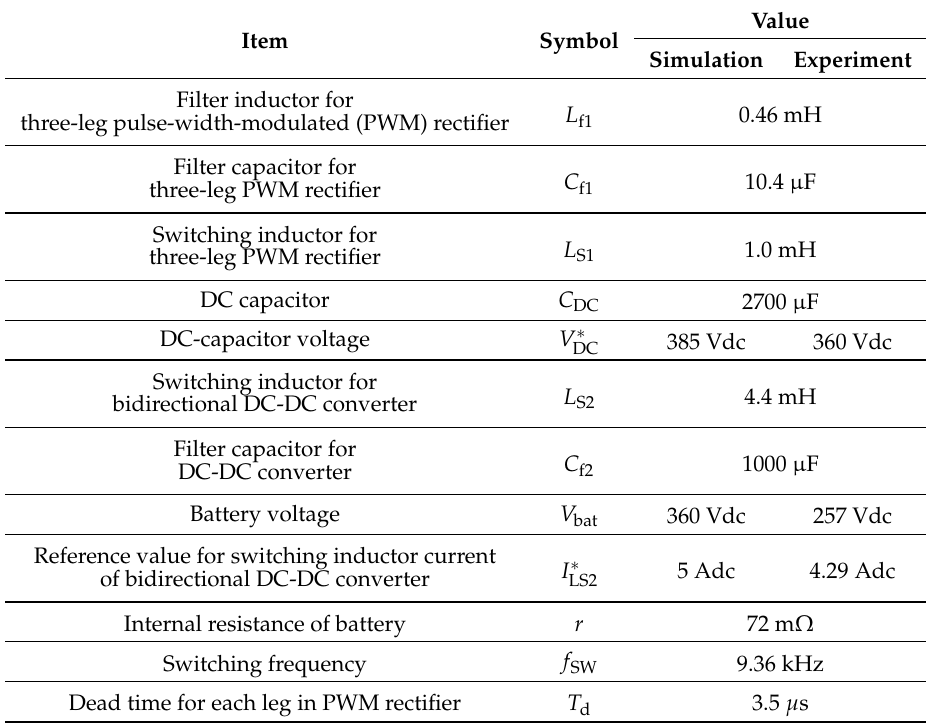
Table 2. Circuit constants for Figure